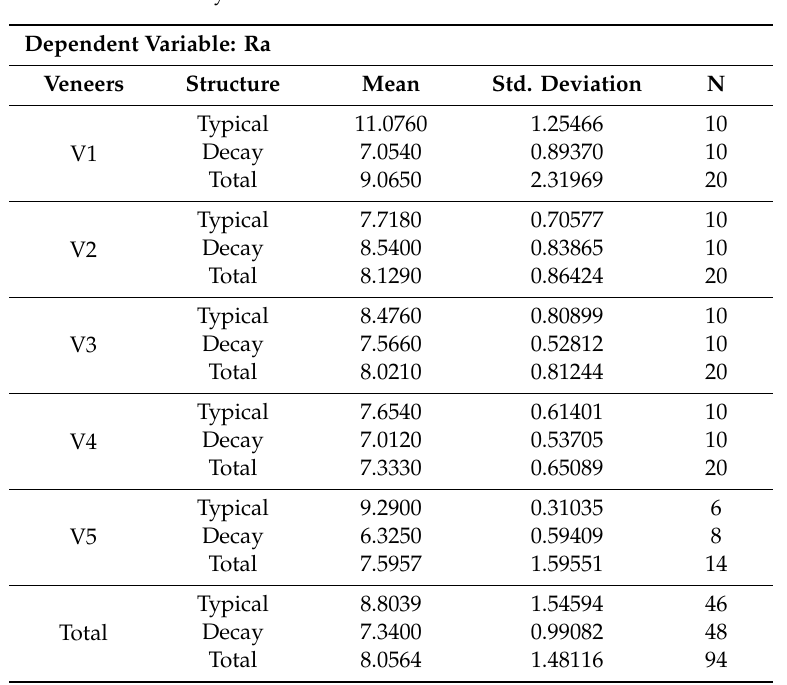
Figure 10. Surface roughness parameters Ra, Rz and Ry (µm) of poplar wood veneers (V1–V5) on typical wood structure areas and around areas of decay. Table 5. Descriptive statistics of dependent variable Ra measured on poplar veneers of typical wood structure areas and areas of decay.